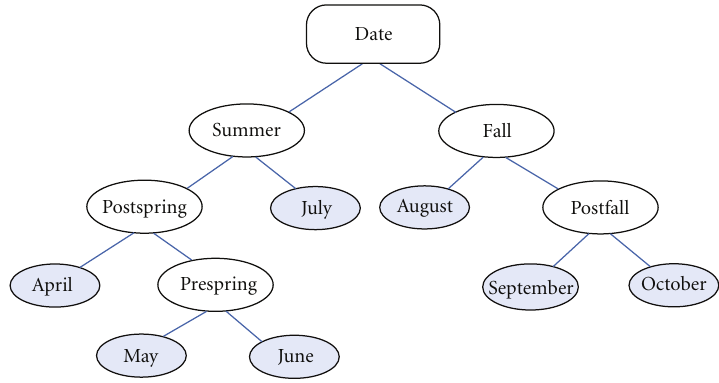
Figure 3: Sample AVT for date attribute of a dataset